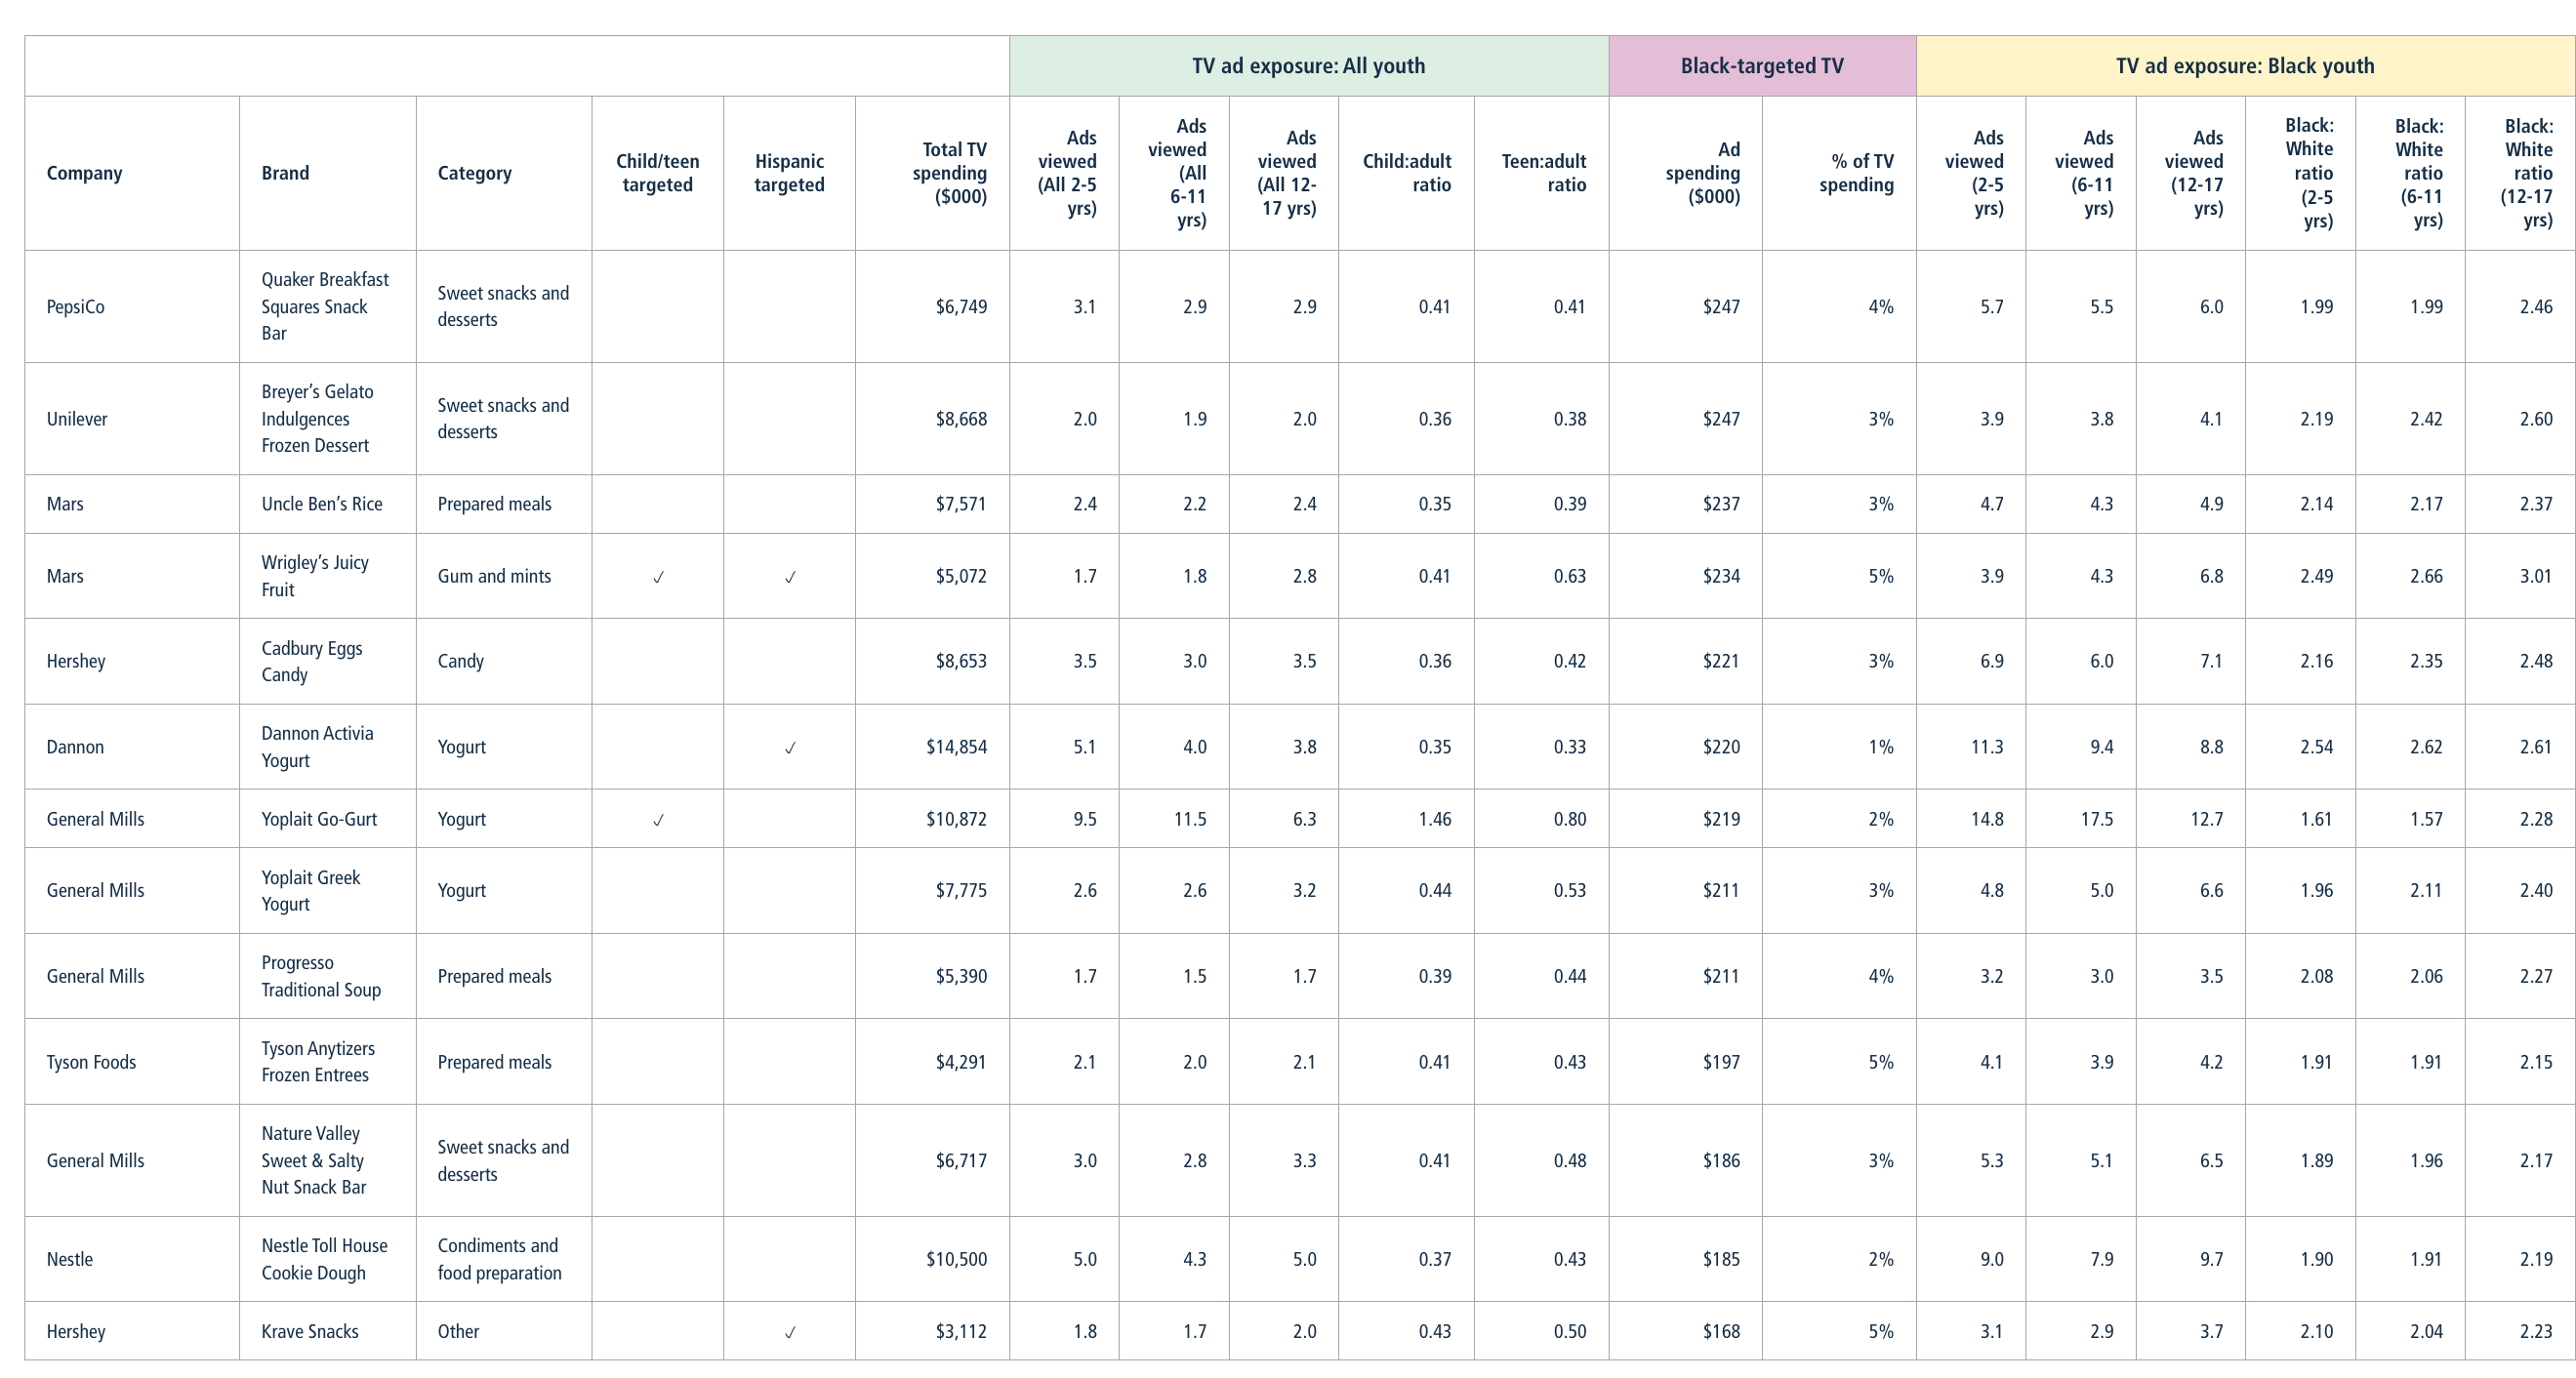
TABLE 3. BRANDS TARGETED TO BLACK CONSUMERS